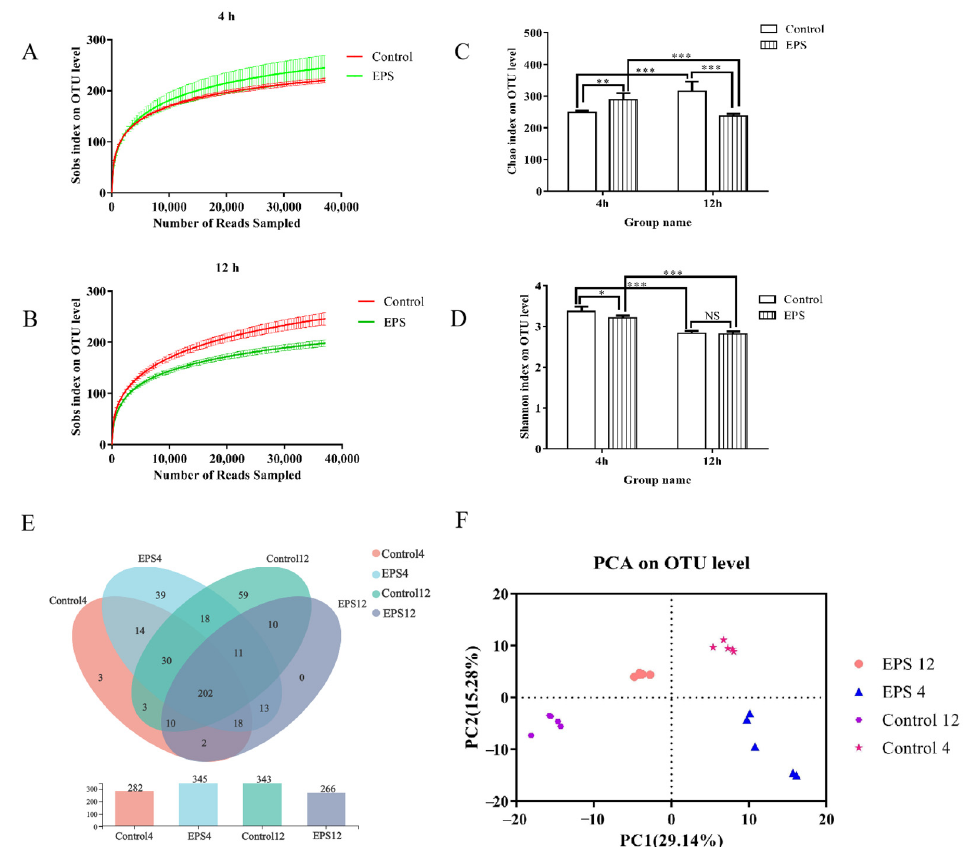
Figure 11. Analysis of DNA sequence data obtained from in vitro fecal fermentation under the intervention of the EPS produced by Lpb. plantarum NMGL2: Rarefaction curves for each experimental group with an incubation time of 4 h ( A ) and 12 h ( B ); α -diversity of fecal microbiota in terms of microbial richness estimates Chao1 ( C ) and diversity indices Shannon ( D ) measured at OTUs definition of >97% identity, p values < 0.05, 0.01, 0.001 are indicated by *, **, ***, respectively; Venn diagrams showing the unique and shared OTUs of different treatment samples ( E ); PCA analysis of fecal microbiota samples ( F ).